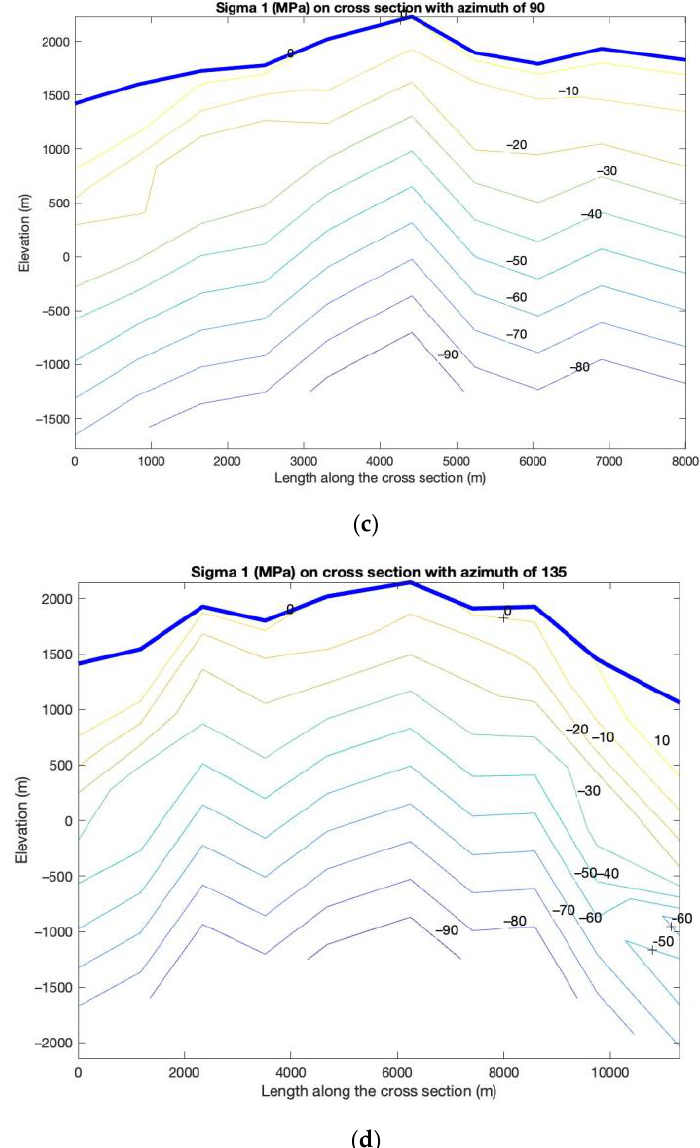
Figure 9. Principal stress magnitude contours without tectonic stress in cross-section views with varying azimuth. ( a ) E-W; ( b ) NW-SW; ( c ) N-S; ( d ) NW-SE.